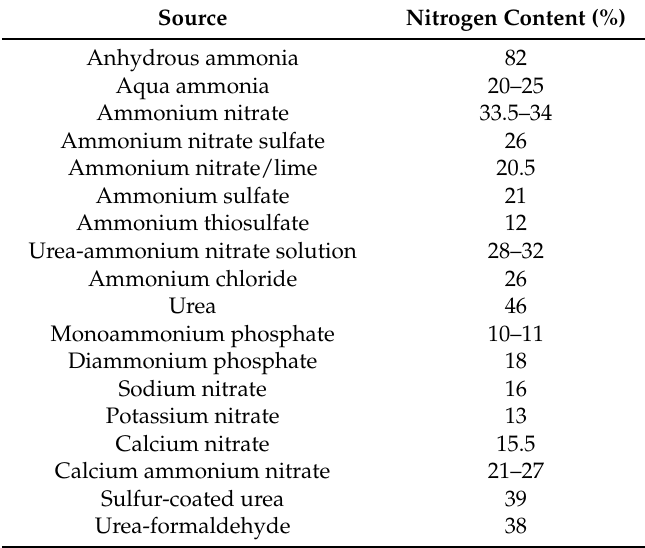
Table 2. Nitrogen sources and their